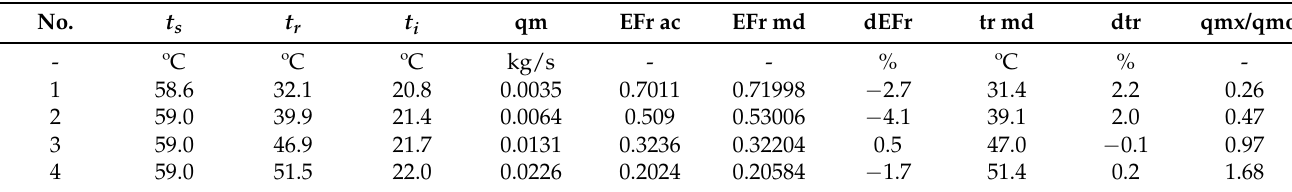
Table 7. The comparison between the measurement results and the simulation calculations Convector Radiator type-8RS , t s = 58.9 ◦ C, Part 2.